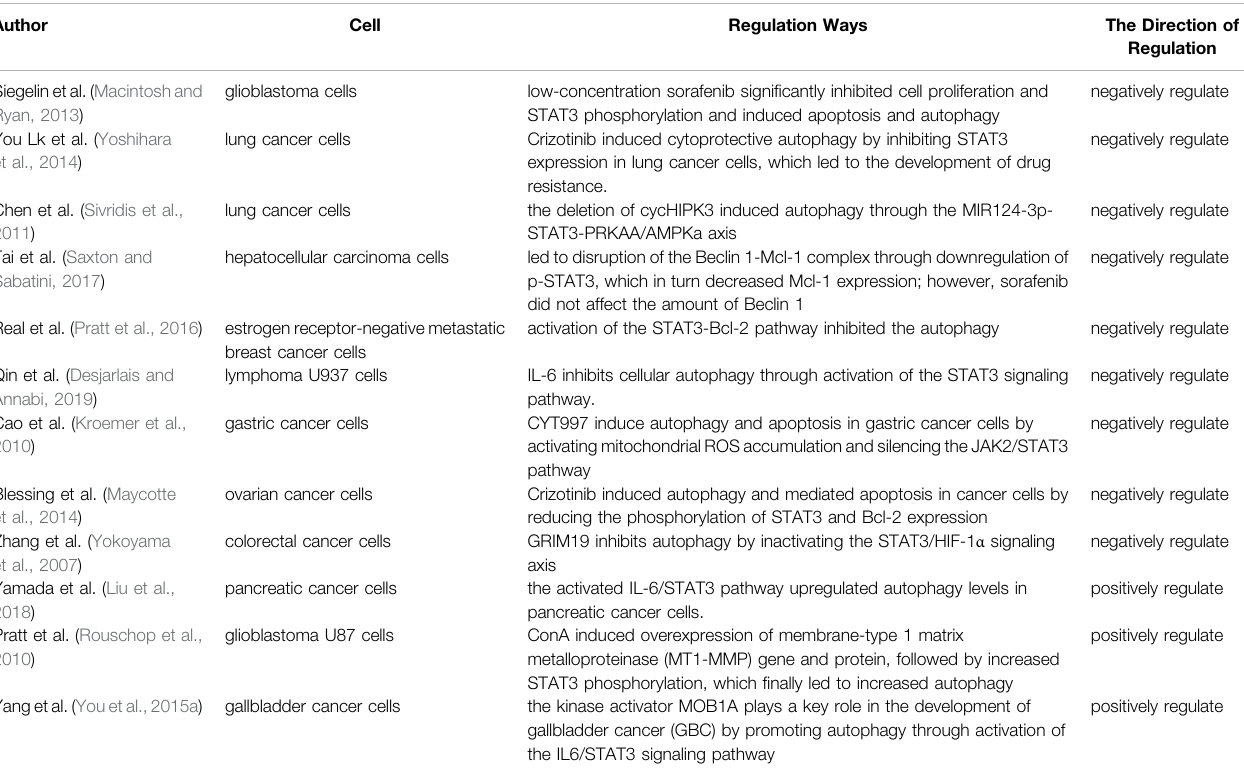
TABLE 1 | Regulation of tumor autophagy by